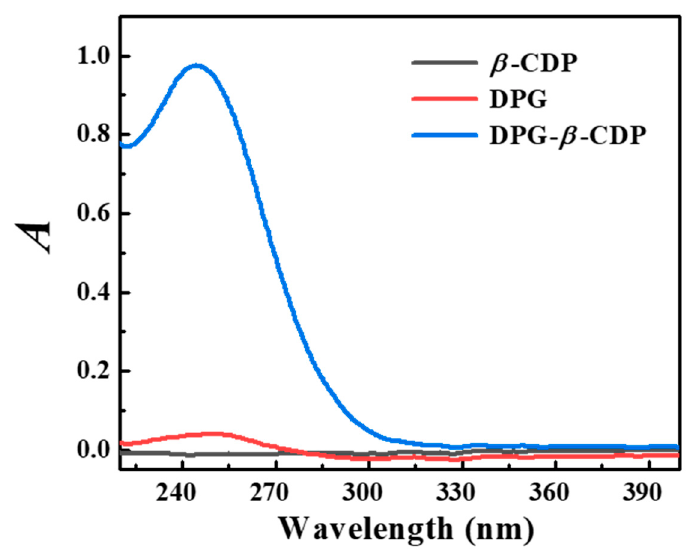
Figure 8. UV-vis spectra of excess DPG, β -CDP, and DPG- β -CDP aqueous solutions.